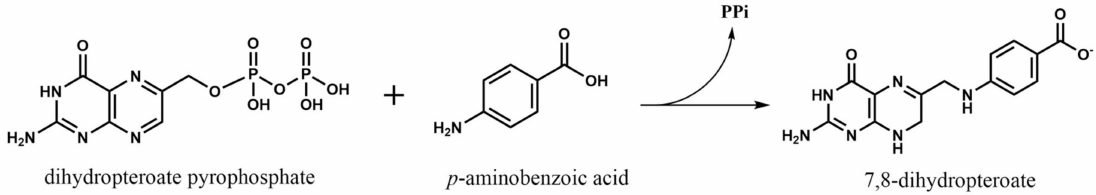
Figure 3. Biosynthesis reaction of 7,8-dihydropteroate catalyzed by dihydropteroate